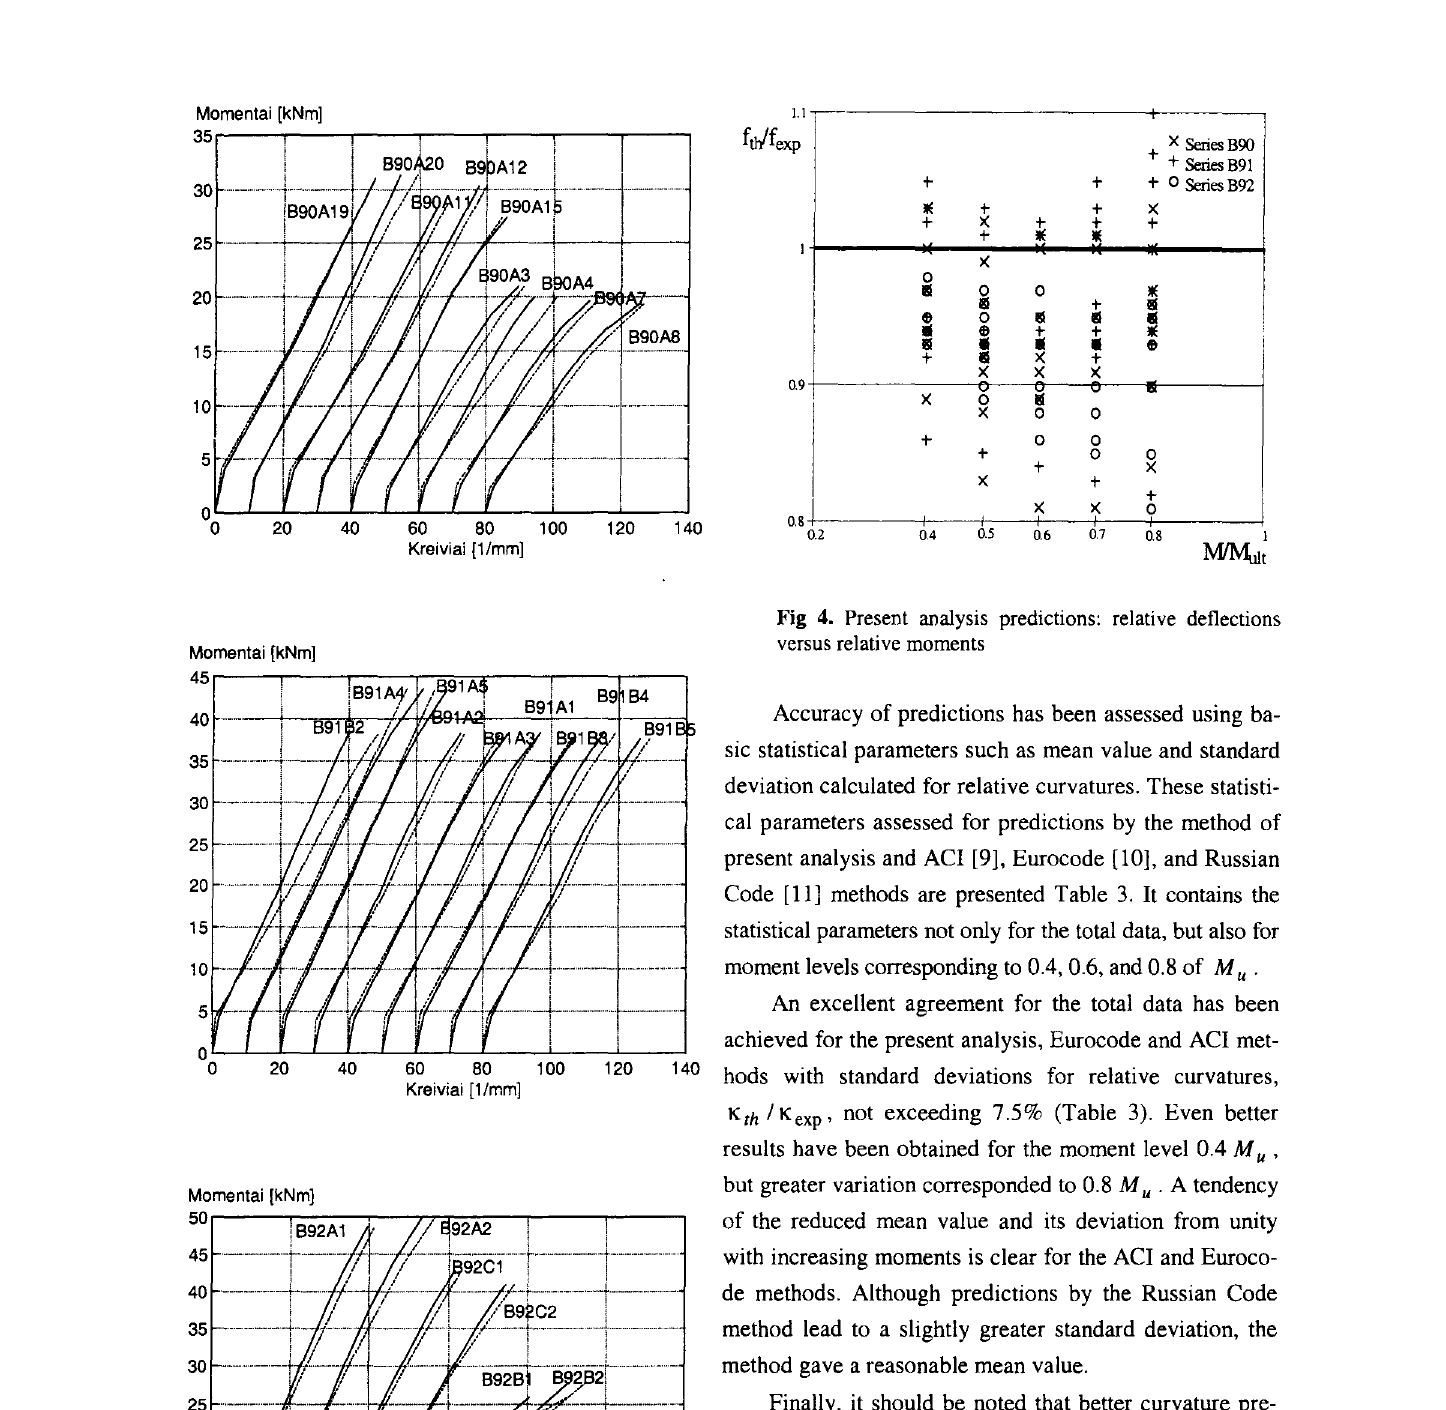
Fig 4. Present analysis predictions: relative deflections versus relative moments Accuracy of predictions has been assessed using ba sic statistical parameters such as mean value and standard deviation calculated for relative curvatures. These statisti cal parameters assessed for predictions by the method of present analysis and ACI [9], Eurocode [10]. and Russian Code [11] methods are presented Table 3. It contains the statistical parameters not only for the total data, but also for moment levels corresponding to 0.4, 0.6, and 0.8 of M u . An excellent agreement for the total data has been achieved for the present analysis, Eurocode and ACI met- Krh IKexp• not exceeding 7.5% (Table 3). Even better results have been obtained for the moment level 0.4 M u , but greater variation corresponded to 0.8 M u. A